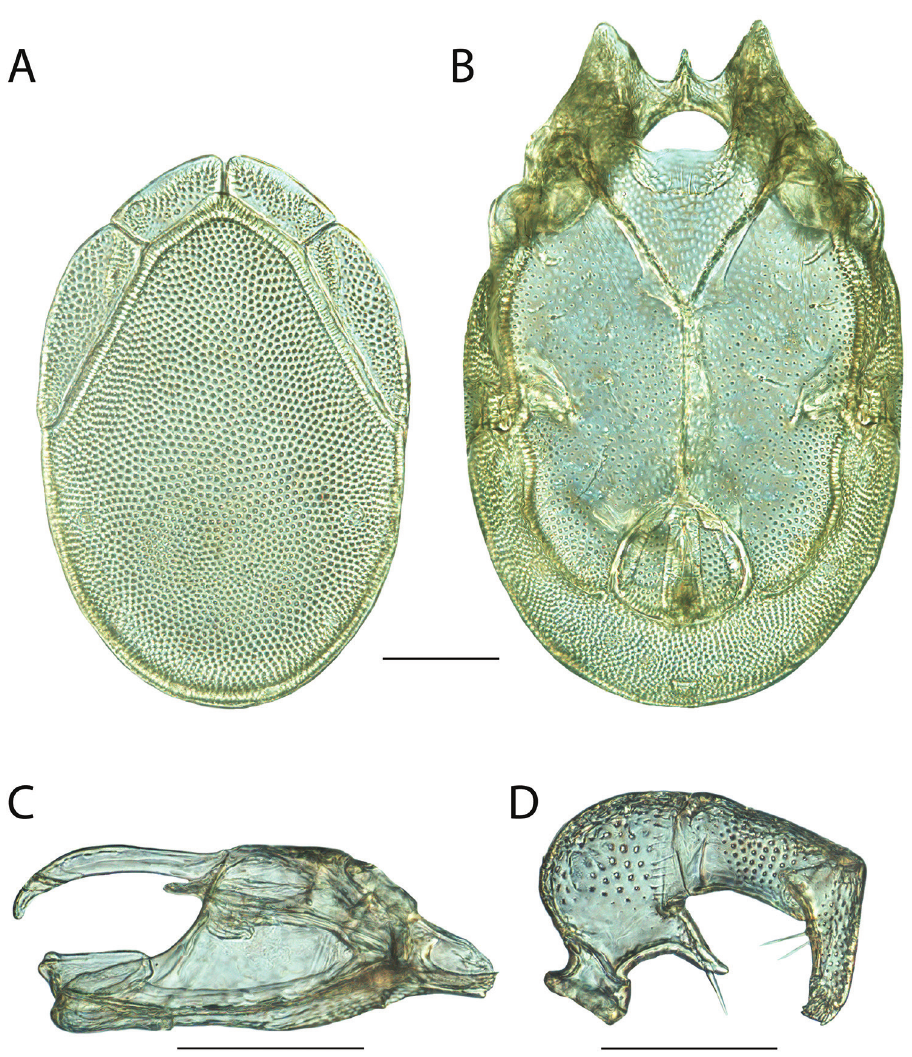
Figure 58. Torrenticola dimorpha sp. n. male: A dorsal plates B venter (legs removed) C subcapitulum D pedipalp (setae not accurately depicted). Scale = 100